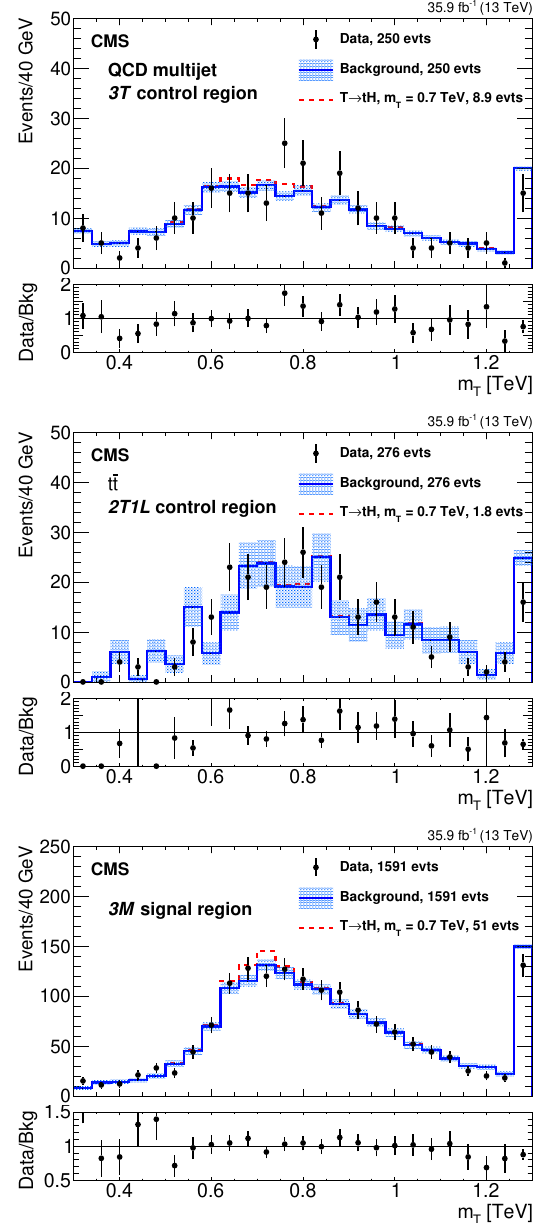
Figure 2 . The (cid:12)ve-jet invariant mass distribution (black points with error bars) for the tHbq channel after the full selection in the QCD multijet 3 T control region (upper), the tt 2 T 1 L control region (middle), and the 3 M signal region (lower). The superimposed blue histogram, labeled \background", is the reweighted 2 M 1 L region distribution, used as an estimate of the background shape, with its normalization adjusted to match the number of entries observed in each region. A potential narrow-width signal (dashed red histogram) is added on top of the blue histogram for m = 0 : 7 TeV and (cid:0) =m = 0 : 01, for a product of signal cross section and branching fraction of T T 600 fb. The light blue shaded area corresponds to the statistical uncertainties in the corresponding 2 M 1 L region. The last bin in each distribution also contains events with masses exceeding 1.3 TeV.